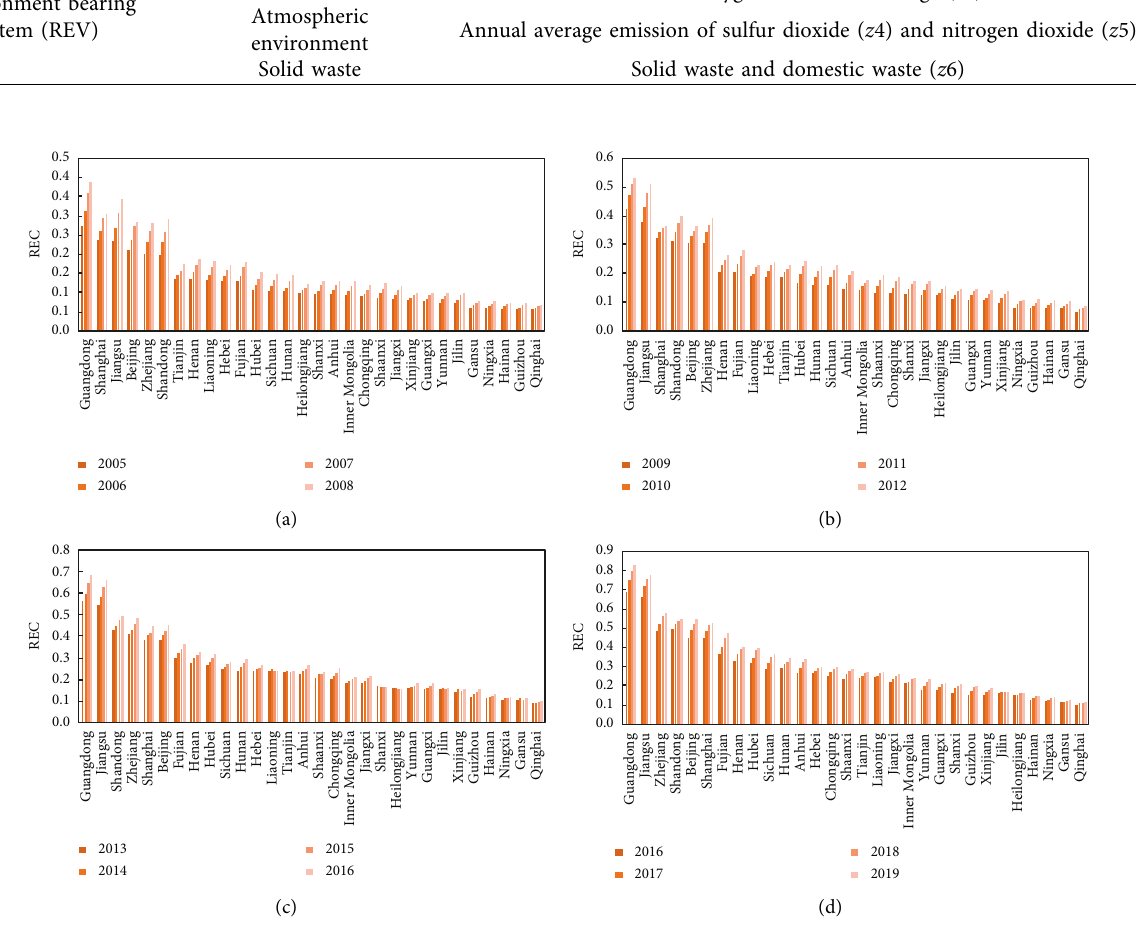
Figure 3: China’s EEE subsystem-REC (2005 ∼ 2019).